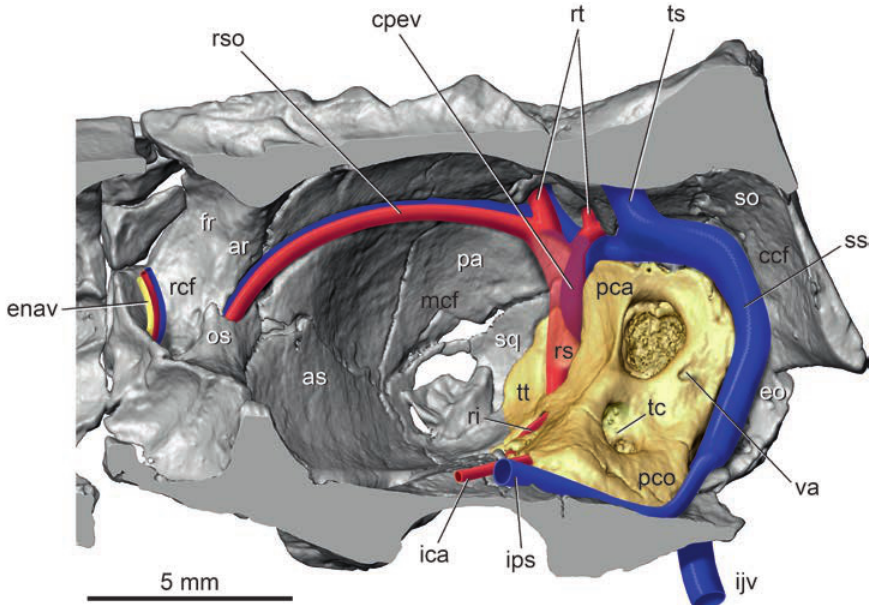
Fig. 4. Palaeoryctid mammal Eoryctes melanus Thewissen and Gingerich, 1989, UM 68074 (UM locality SC-133, Clarks Fork Basin, Wyoming, USA; early Wasatchian Land-Mammal Age, early Eocene), isosurface of right endocranium rendered from CT scans in ventral view, with neurovascular struc- tures reconstructed based in part on Avizo segmentation (petrosal in gold; arteries in red; veins in blue; nerves in yellow). Segment of ramus superior is transparent to show hidden capsuloparietal emissary vein; holes in squamosal are damage. Abbreviations: ar, annular ridge; as, alisphenoid; ccf, caudal cranial fossa; cpev, capsuloparietal emissary vein; enav, ethmoidal nerve, artery, and vein; eo, exoccipital; fr, frontal; ica, internal carotid artery; ijv, inter- nal jugular vein; ips, inferior petrosal sinus; mcf, middle cranial fossa; os, orbitosphenoid; pa, parietal; pca, pars canalicularis; pco, pars cochlearis; rcf, rostral cranial fossa; ri, ramus inferior; rs, ramus superior; rso, ramus supraorbitalis with accompanying vein; rt, ramus temporalis with accompanying vein; so, supraoccipital; sq, squamosal; ss, sigmoid sinus; tc, transverse crest; ts, transverse sinus; tt, tegmen tympani; va, vestibular canal (Fig. 5: npc). The nerve of the pterygoid canal crosses